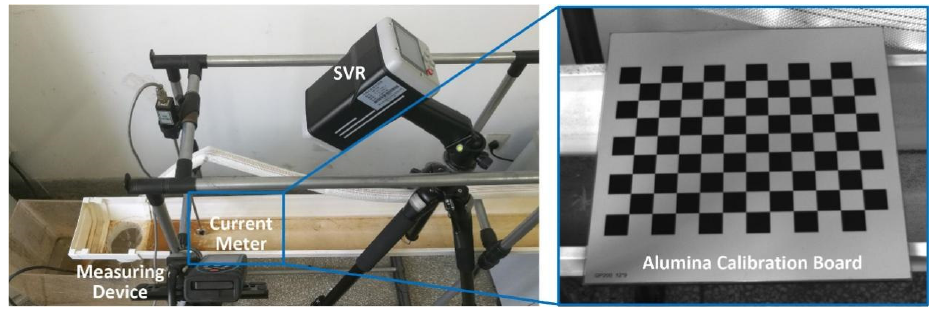
Figure 8. Flume experiment settings. Table 3. Calibration results of eccentric distances and camera elevation to flume bottom.